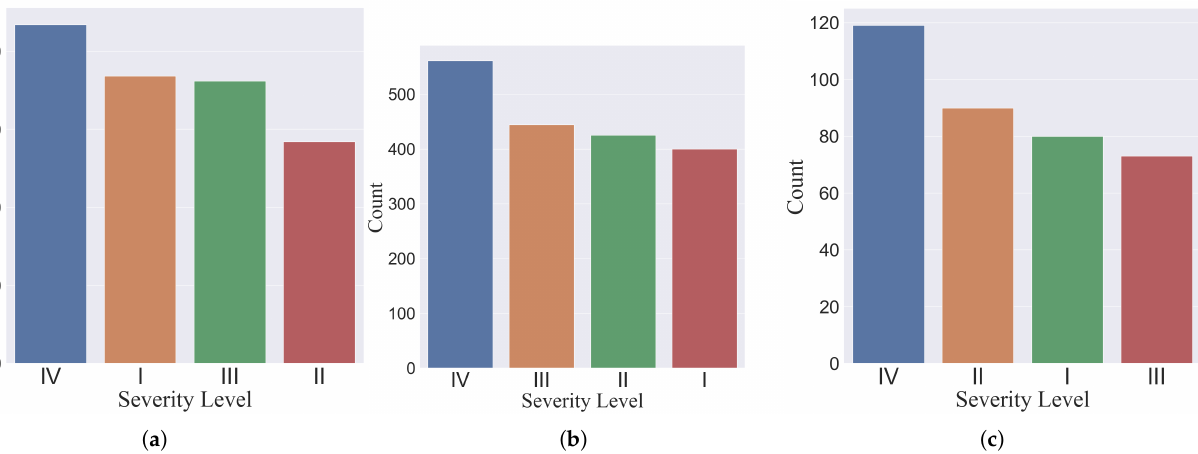
Figure 6. Distribution of data set according to each class for the ( a ) KNN, ( b ) SVM and ( c ) GB